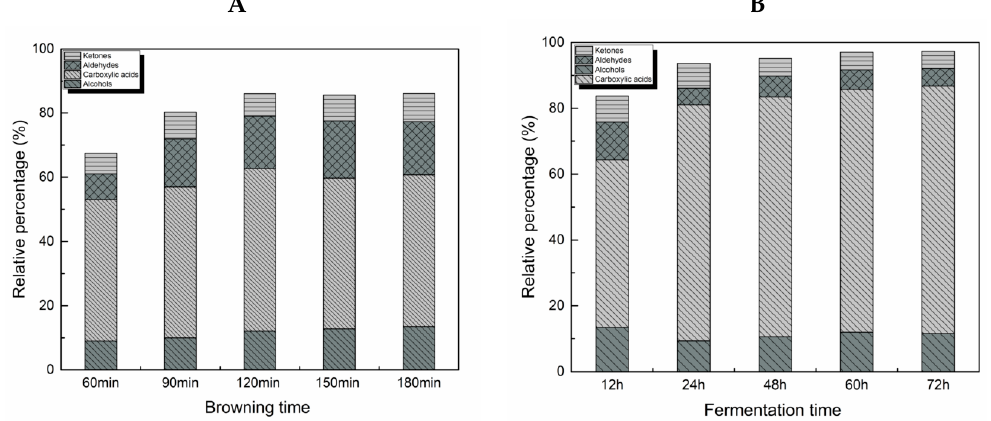
Figure 1. Changes in the relative percentage of flavour components identified in the brown fermented milk (BFM). ( A ) Changes during the browning stage. ( B ) Changes during the fermentation stage.